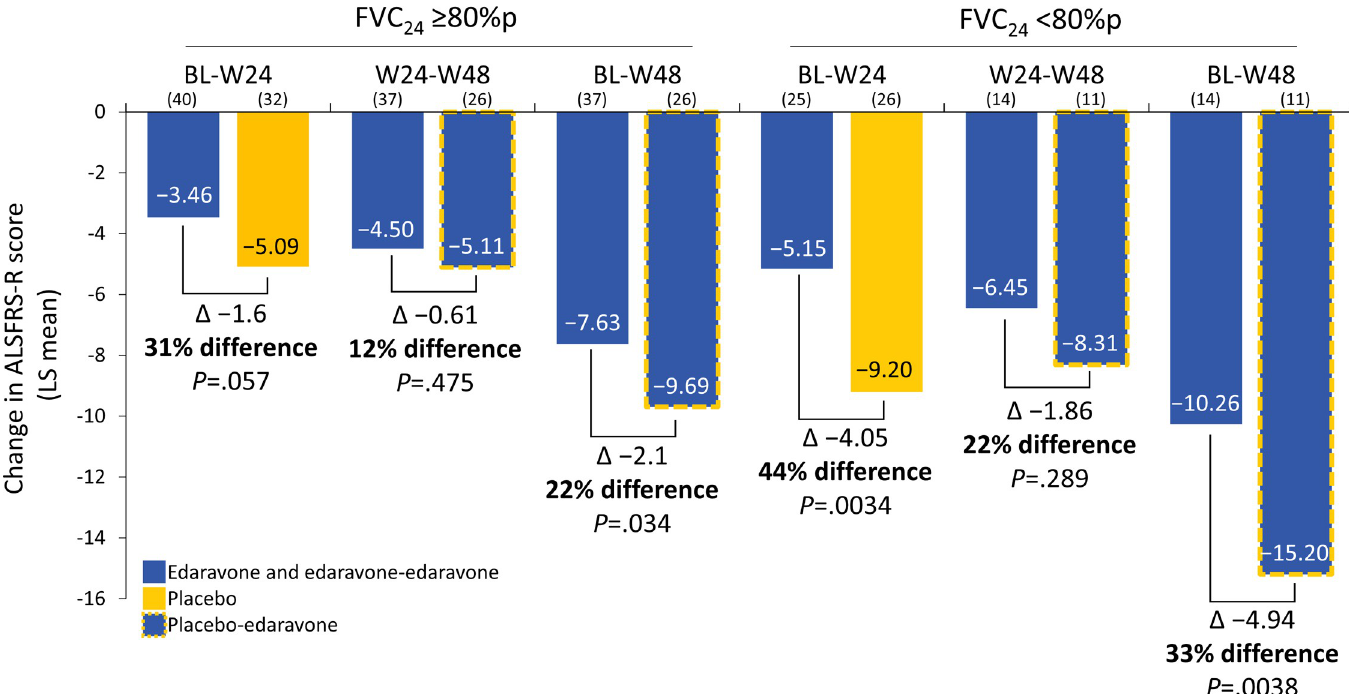
Fig 3. Change in ALSFRS-R scores in FVC 24 subgroups. Change in ALSFRS-R scores (LS means) in the FVC 24 � 80%p and FVC 24 < 80%p subgroups for baseline to week 24 (BL-W24), week 24 to week 48 (W24-W48), or baseline to week 48 (BL-W48) (edaravone, blue columns; placebo, yellow columns; placebo followed by edaravone, blue columns with yellow dashed outlines). A mixed-effects model for repeated measures (MMRM) analysis was conducted on observed cases. LS mean differences and percentage differences between treatment arms are shown. The subject number included in each analysis is shown in parentheses just above each data column. Note that 5 subjects did not have cycle 12 ALSFRS-R data and were not included in the analysis. ALSFRS-R, Amyotrophic Lateral Sclerosis Functional Rating Scale-Revised; BL, baseline; FVC 24 , forced vital capacity in 24 weeks; LS, least squares; W,